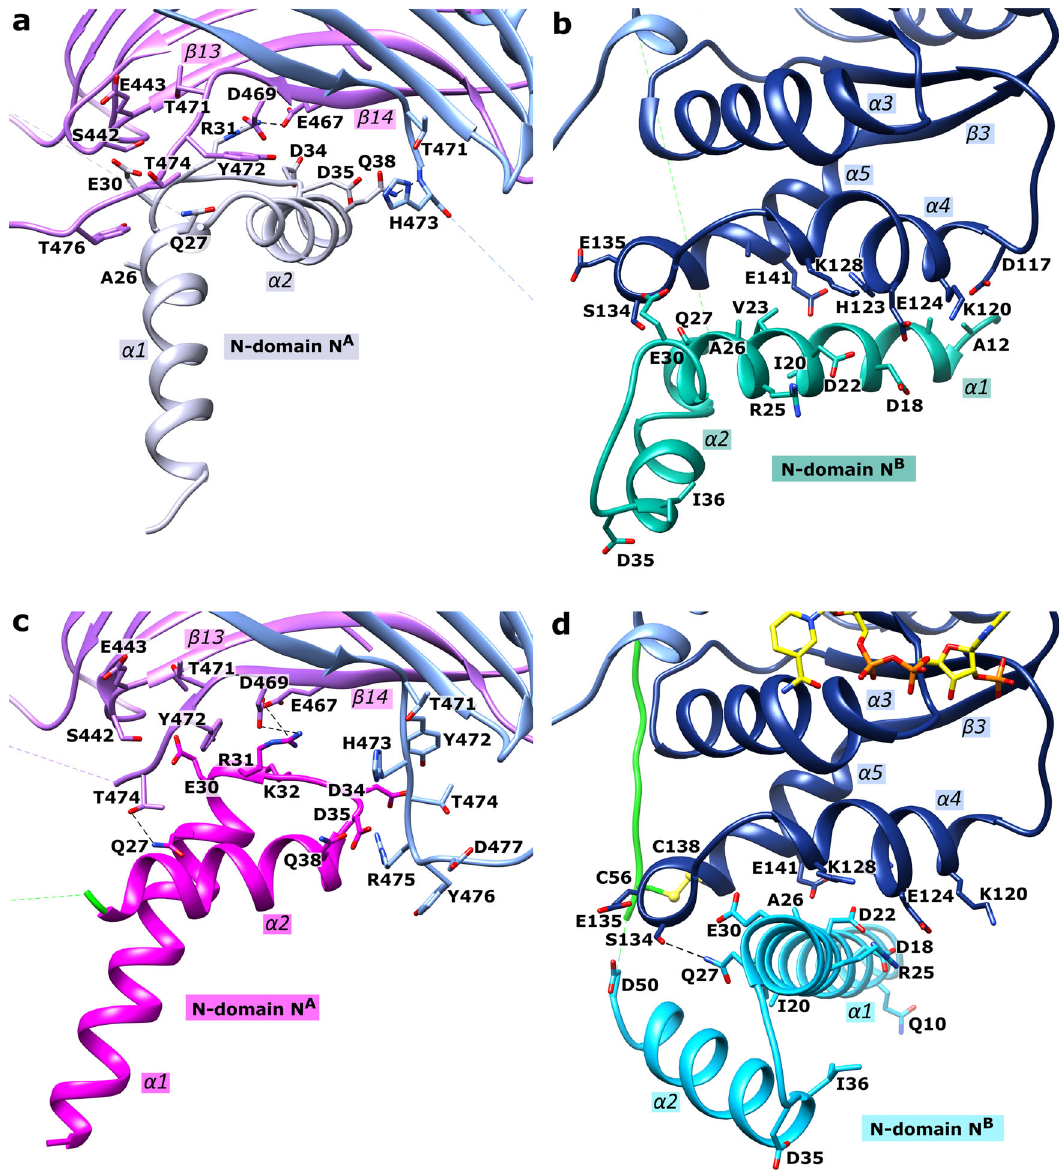
Fig. 4 Close-up of the Ld G6PD wt N-domains. The dimers of the apo and the NADP(H)-complexed structures are shown in the same orientation (PDBIDs: 7ZHT, 7ZHU). The β - α domain of subunits A or B are colored light purple and light blue, respectively. The “ Rossmann-like ” domain of subunit B is colored navy blue. The connecting loop (D50-K64) is colored green. a apo structure: N-domain A (N A ) is colored gray. b apo structure: N-domain B (N B , position P1) is colored dark cyan. c NADP(H)-complexed structure: N-domain A (N A ) is colored magenta. d NADP(H)-complexed structure: N-domain B (N B , position P1) is colored cyan; NADP(H) is colored yellow. Important residues are shown in stick models and hydrogen bonds are indicated with black dotted lines. Respective α -helices and β -sheets are